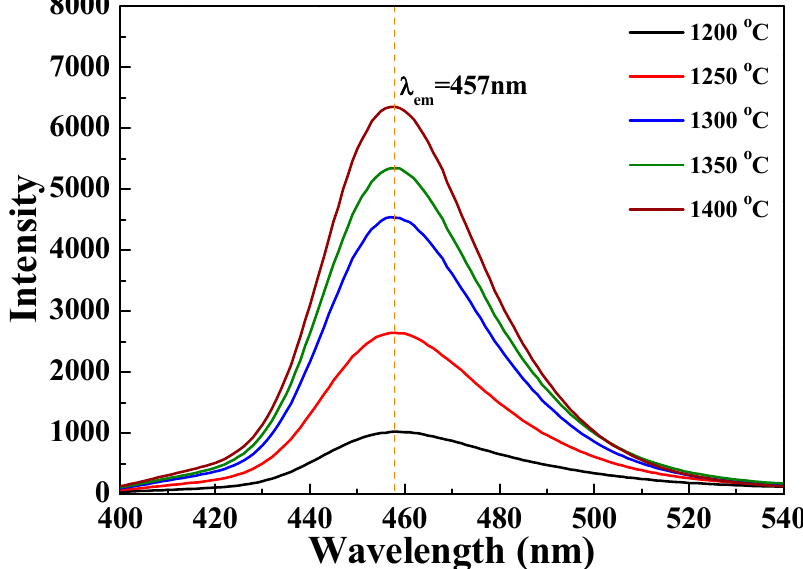
Figure 12. PL spectra of the [Sr 0.99 Eu 0.01 ] 3 MgSi 2 O 8 phosphors sintered at different temperatures.